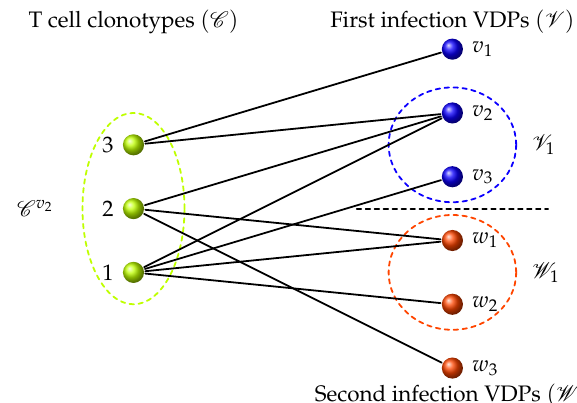
Figure 6. Bipartite recognition network generalizing the model developed by Stirk et al. [56–60]. Each green circle (or node) represents a T cell clonotype. Each blue or red circle represents a VDP node from a first and second infection, respectively. An edge between a green and a blue or red node represents the ability of that clonotype to recognize the VDP it is connected to. For any VDP, v , the set of clonotypes that can recognize it is denoted by C v , and for a given clonotype, i , the set of first infection VDP it can recognize is denoted by V i , and the set of second infection VDPs it can recognize is denoted by W i . For example, in the bipartite recognition network chosen, the set C v 2 consists of clonotypes 1, 2 and 3; the set C w 2 consists of clonotype 1; the set V 3 = { v 1 , v 2 } ; the set W { w } ; and the set W { ∅ } 2 = 3 = 1 , w 3